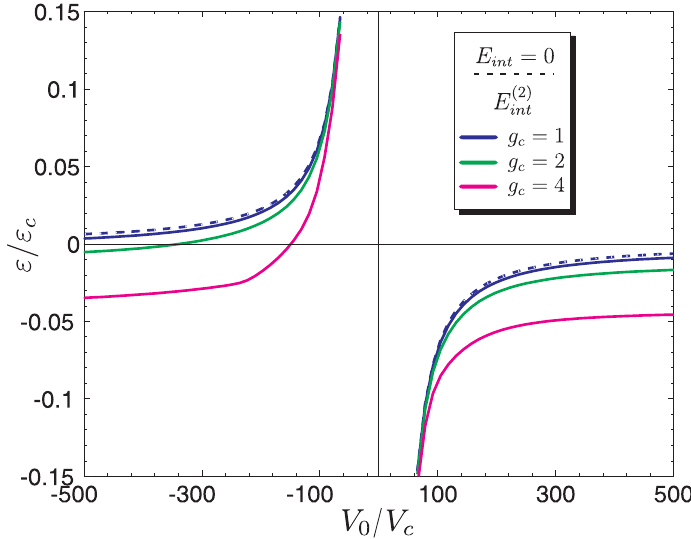
Figure 6. Resonant energy levels ε with consideration of magnetic interaction E int as a function of renormalized impurity potential V 0 for different values of coupling constant g c